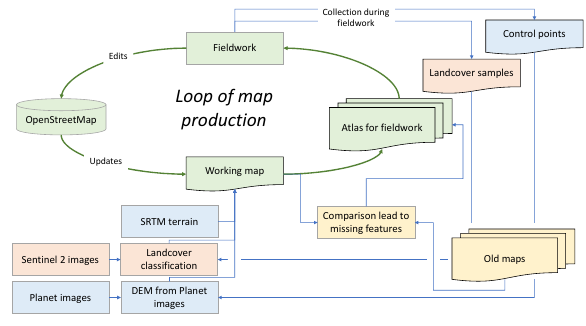
Figure 3. The use of dynamic working map and field atlas in the process of updating and augmenting